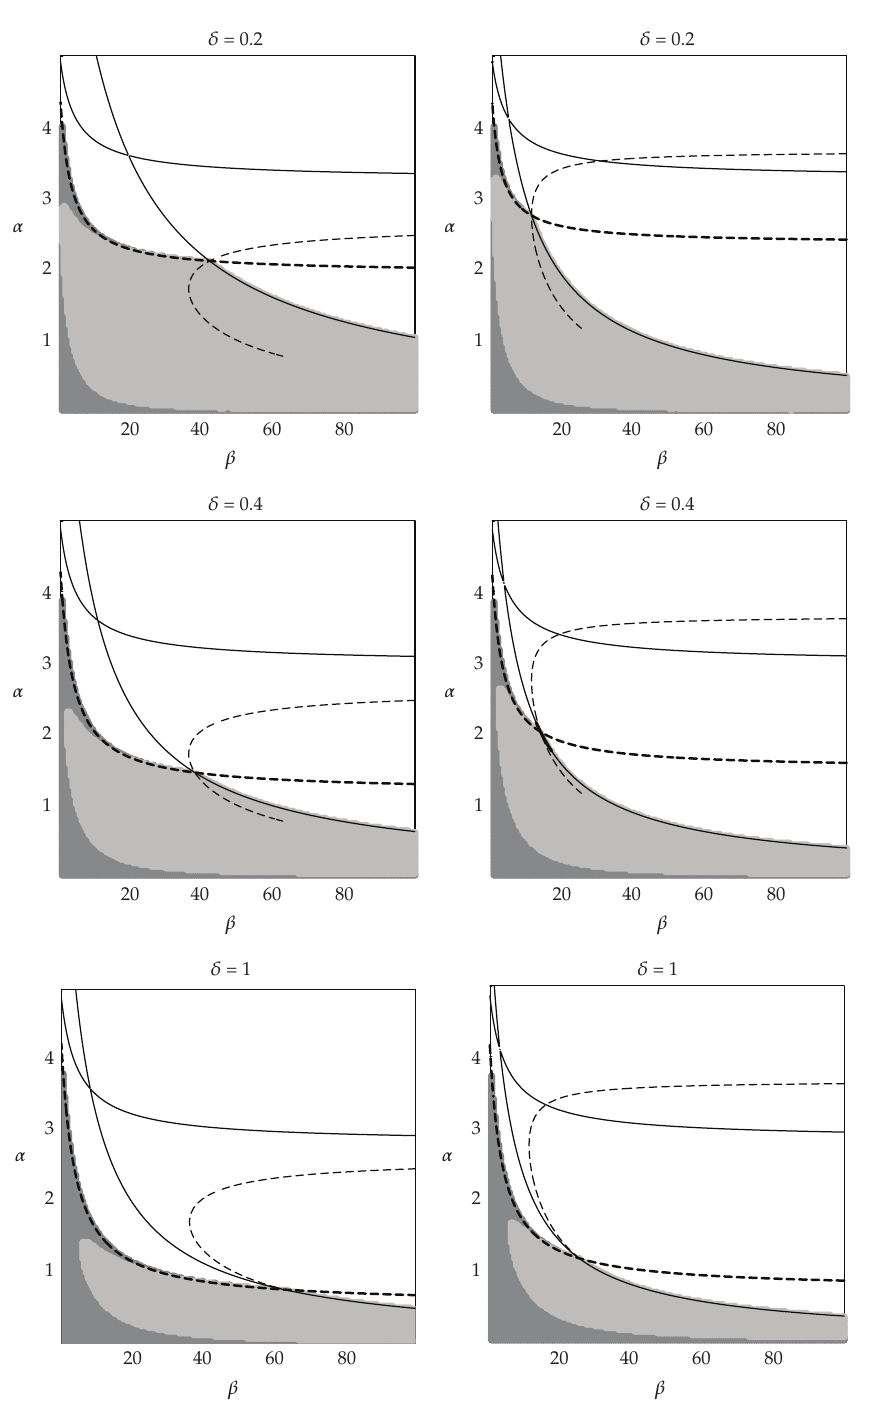
Figure 10: Regions of stability for γ (cid:9) 1 . 4 (cid:4) left (cid:7) and γ (cid:9) 1 . 6 (cid:4) right (cid:7)